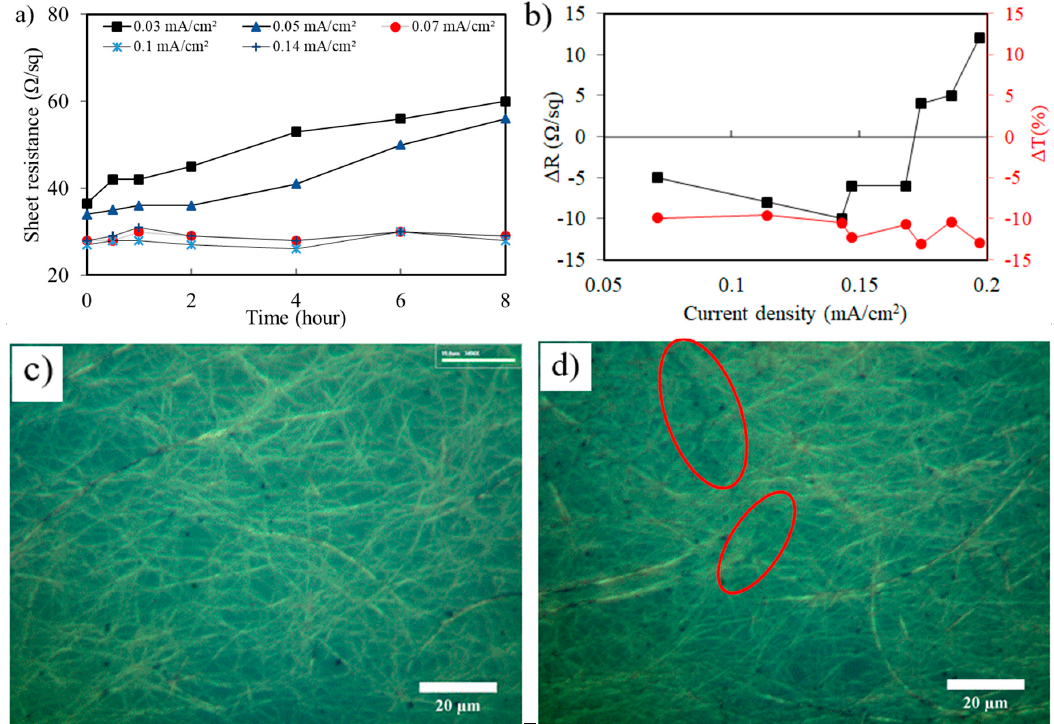
Figure 9. ( a ) The change in the sheet resistance of Cu–Ni NW electrodes which are plated at di ff erent average currents (mA / cm 2 ) while heating at 150 ◦ C on a hot plate for 8 h ( b ) the change in the sheet resistance and transmittance of the electrode when an increasing current density is applied during PC plating, ( c ) microscope image showing an absence of cracks, ( d ) microscope image of cracks (red circle) as a result of PC plating at current density of 0.14 mA / cm 2 and 0.18 mA / cm 2 , respectively.